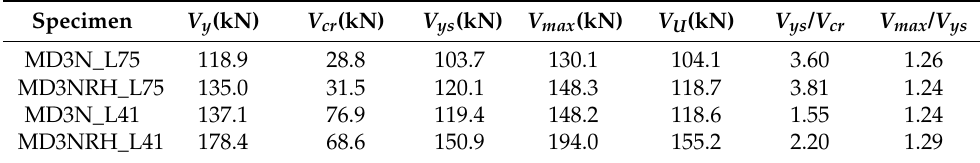
Table 4. Shear strength for the critical points of the envelope and elastoplastic